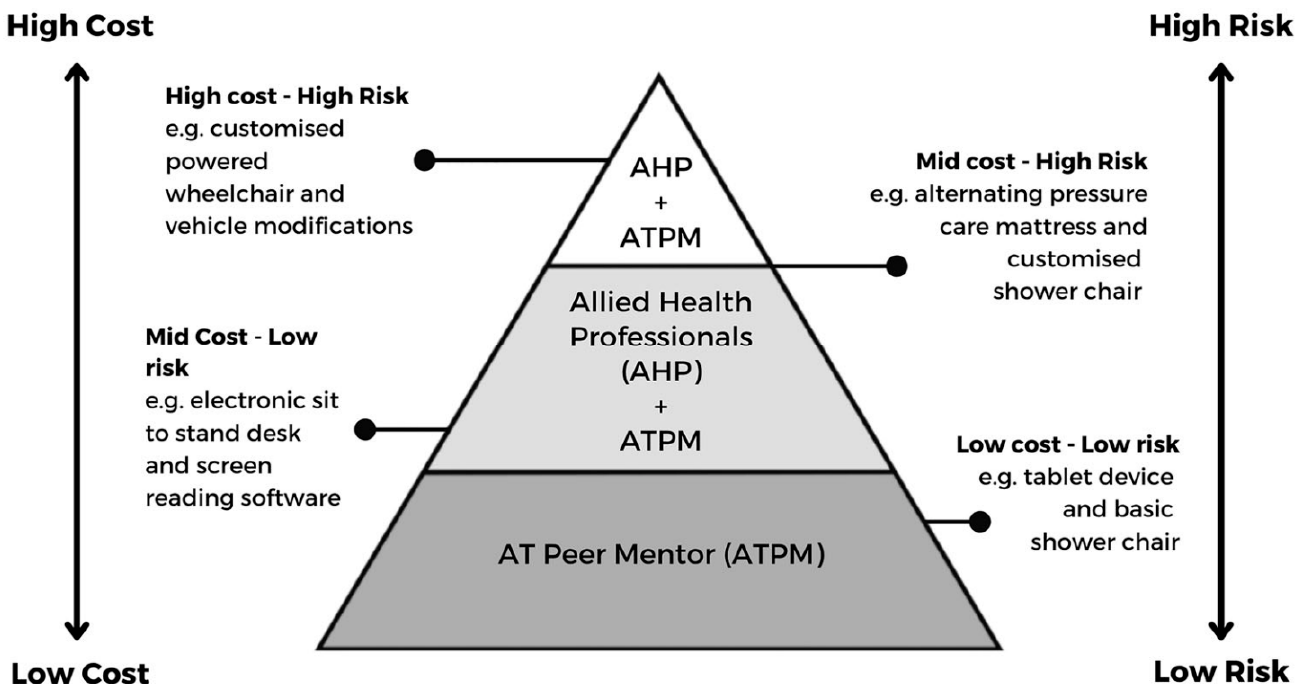
Figure 3. AT Risk levels and AT roles for AHP and AT Peer Mentors (ATPM) (reproduced with permission [50]).